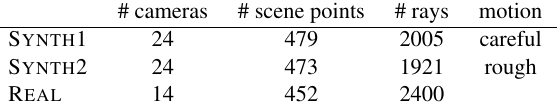
Table 1: Overview of the three evaluated data sets.